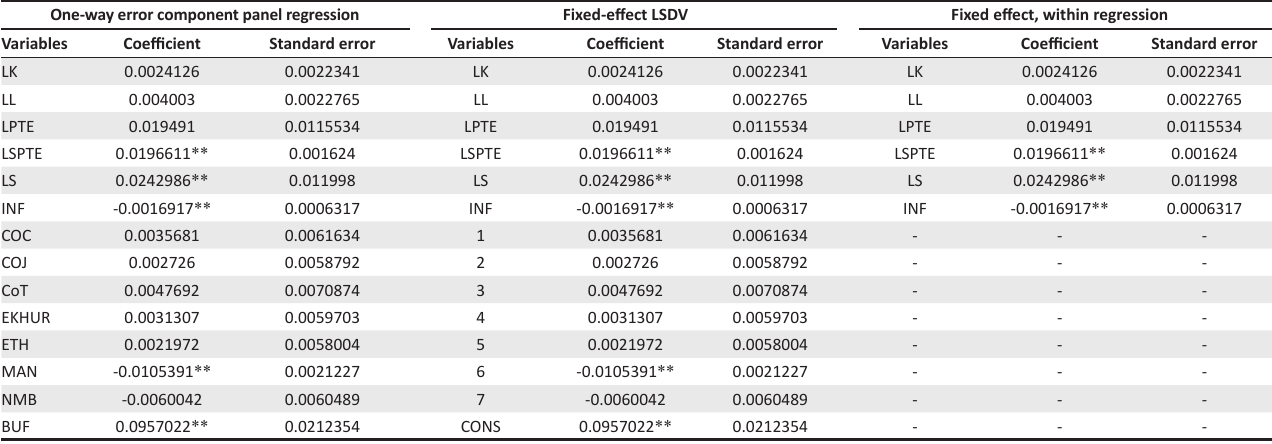
TABLE 3: Panel data results. One-way error component panel